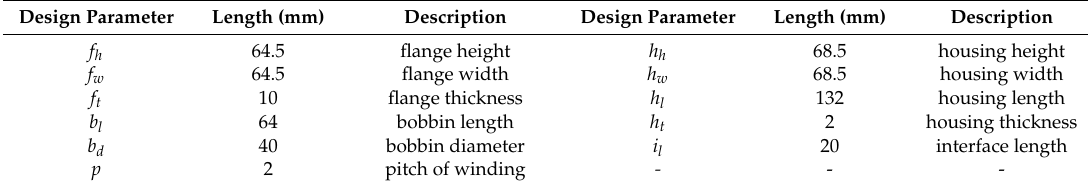
Figure 4. Structure of prototype 30-turn single-layered solenoid. ( a ) Drawing in front view; ( b ) Drawing in port side view; ( c ) A picture from above with radio frequency (RF) cables connected and with upper housing removed. Table 1. Design parameters of the prototype single-layered